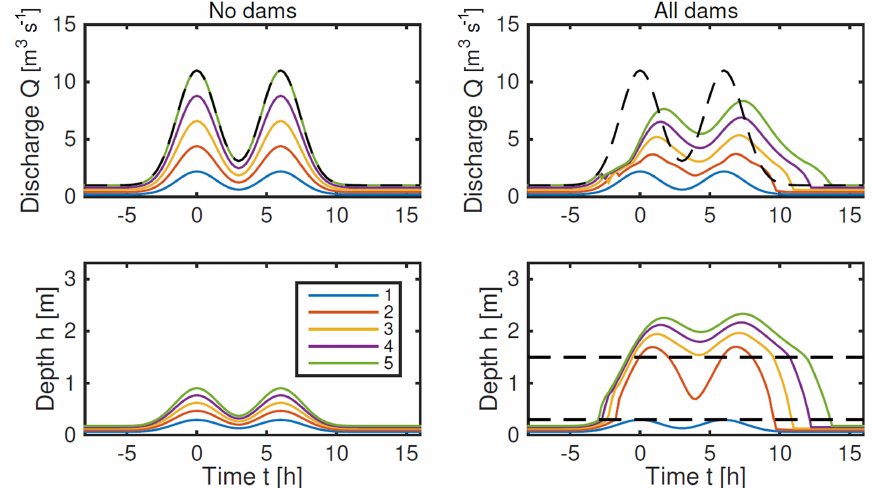
Figure 6. Solutions for a one-dimensional network as in Fig. 2b, forced by a double-peaked input to each node. Parameter values are as in Fig.